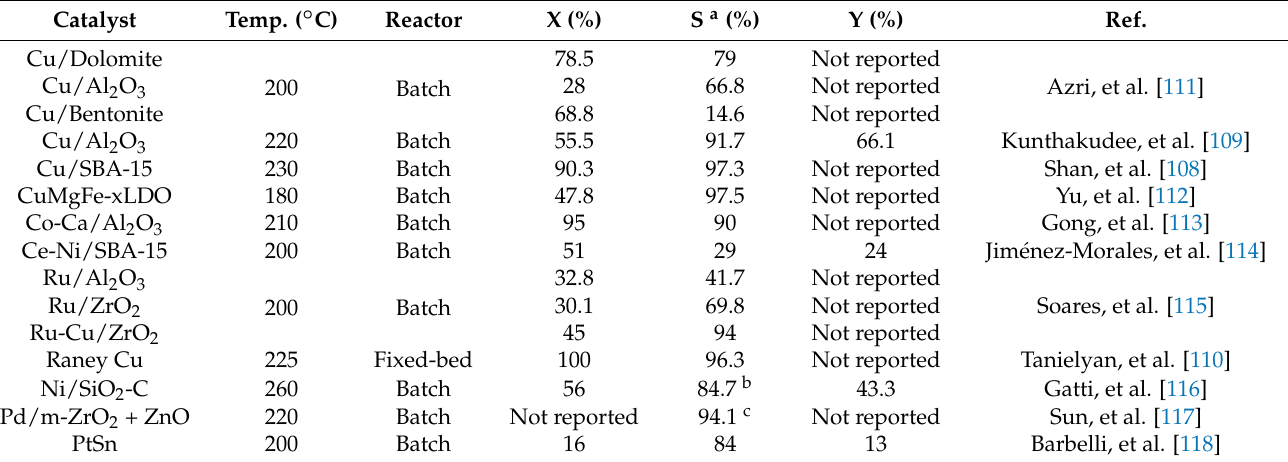
Table 2. Heterogeneous catalyst used for glycerol hydrogenolysis to 1,2-propanediol (X = conversion, S = selectivity, Y =